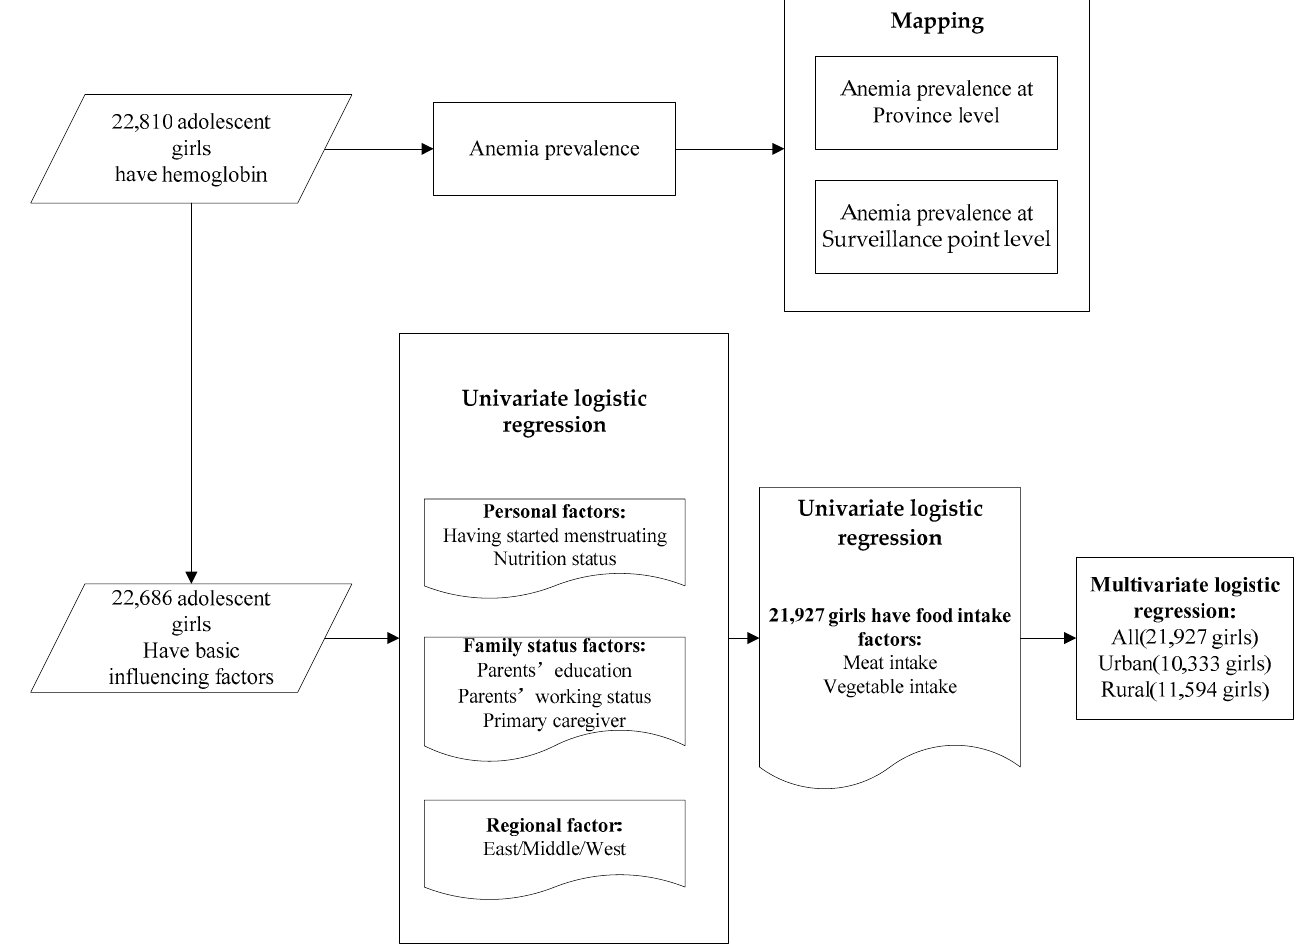
Figure 1. The flowchart of study procedures.